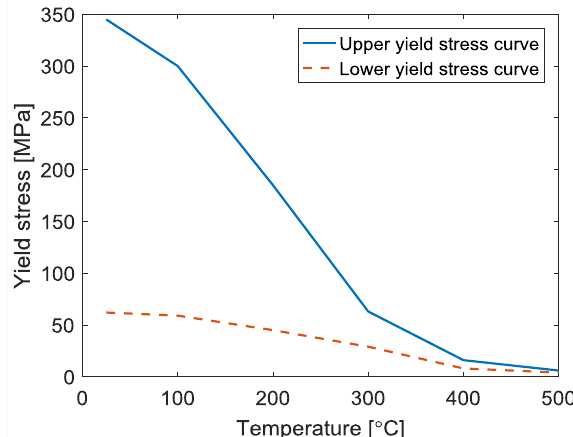
Figure 1. The yield stress as a function of temperature given as two curves for the upper full T3 condition containing the precipitates in the microstructure and the lower yield stress curve for the fully softened material, obtained if the precipitates are fully dissolved, as presented by Sonne et al. [9].